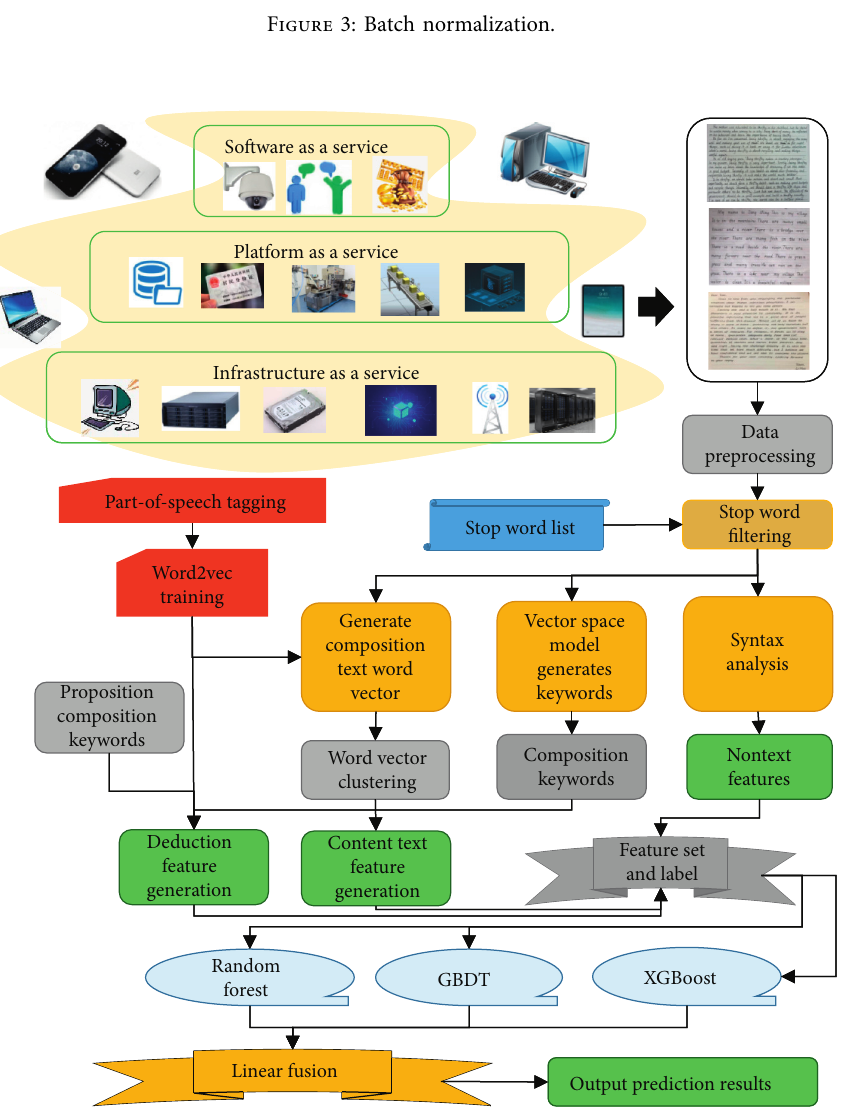
Figure 4: Automatic scoring model for English composition.